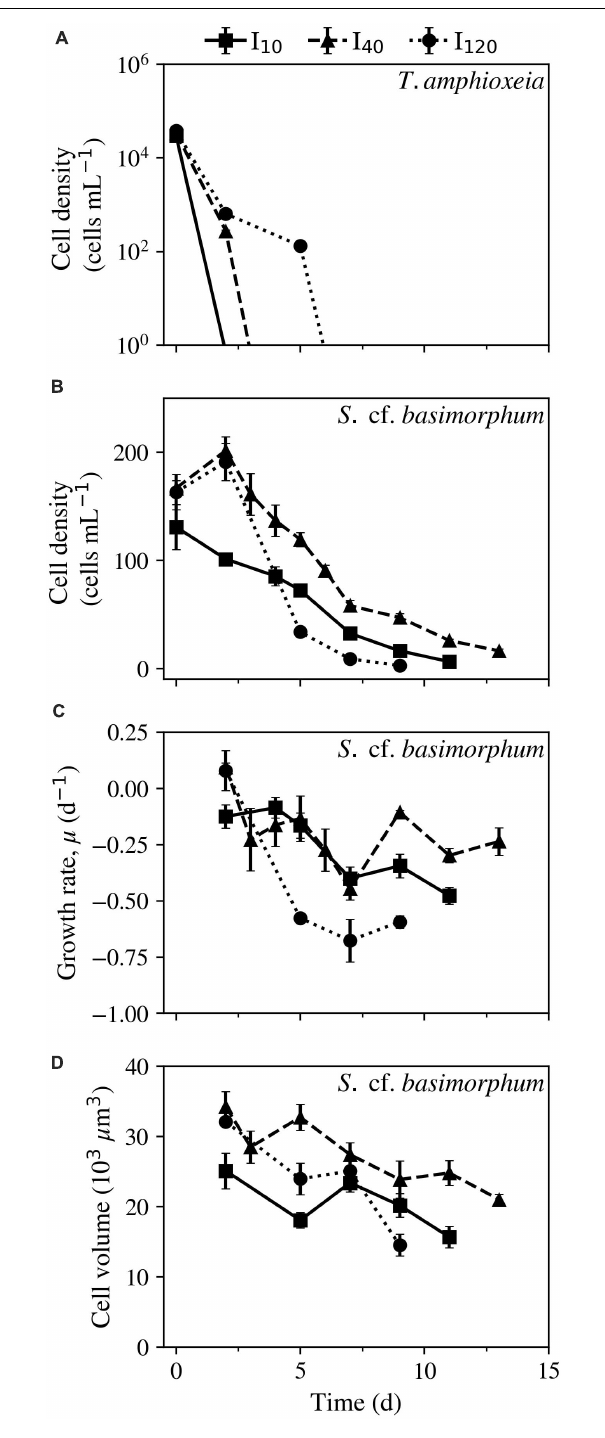
FIGURE 2 | Experiment 1: Physiological responses of Strombidium cf. basimorphum to prey starvation at three different light treatments (I 10 , I 40 , and I 120 ) as a function of time (d). (A,B) Cell densities of T. amphioxeia and S. cf. basimorphum , respectively. (C) Growth rate of S. cf. basimorphum . (D) Biovolume of Lugol-fixed ciliate cells. Solid, dashed, and dotted lines denote light treatments I 10 , I 40 , and I 120 , respectively. Data points are means ± STD ( n = 3).